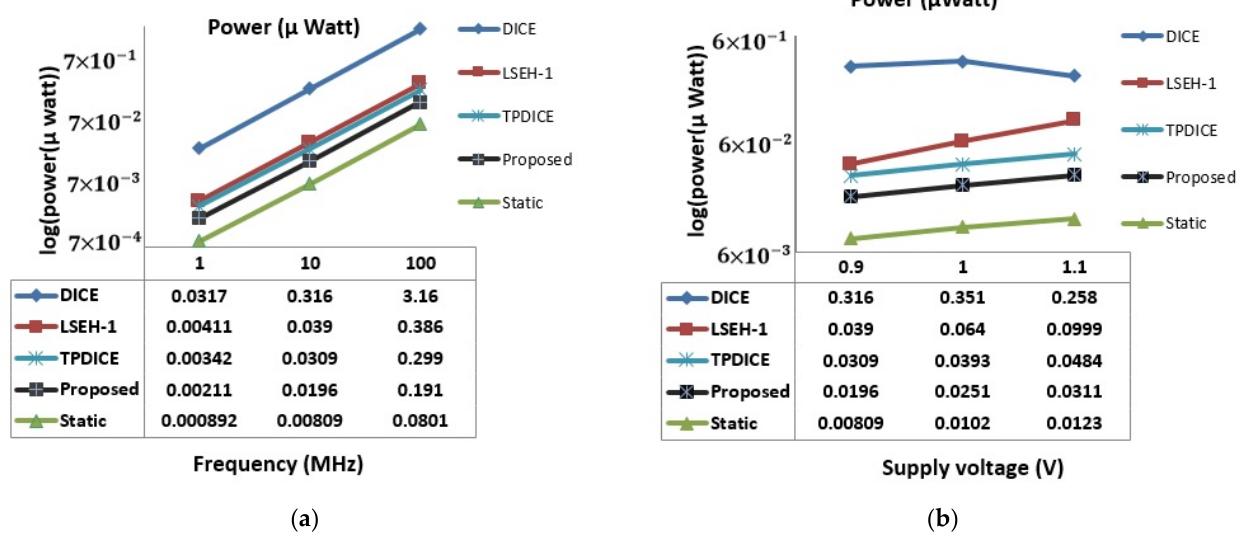
Figure 7. Power consumption of various D-latches: ( a ) at three frequencies from 1 MHz to 100 MHz and 0.9 V power supply voltage; ( b ) at three supply voltages and 10 MHz input frequency.